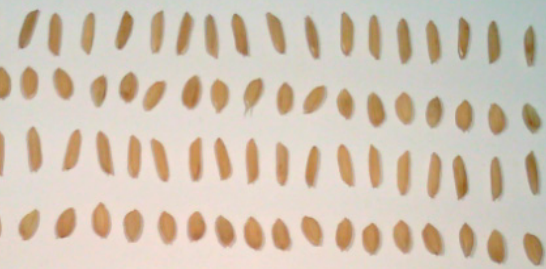
Figure 2. Image of four rice seed samples through the viewfinder of the hyperspectral camera; the first (top) to fourth (bottom) rows are Huguangxiang, Xiangwan Japonica, Huanghuazhan, and Japonica 530, respectively.